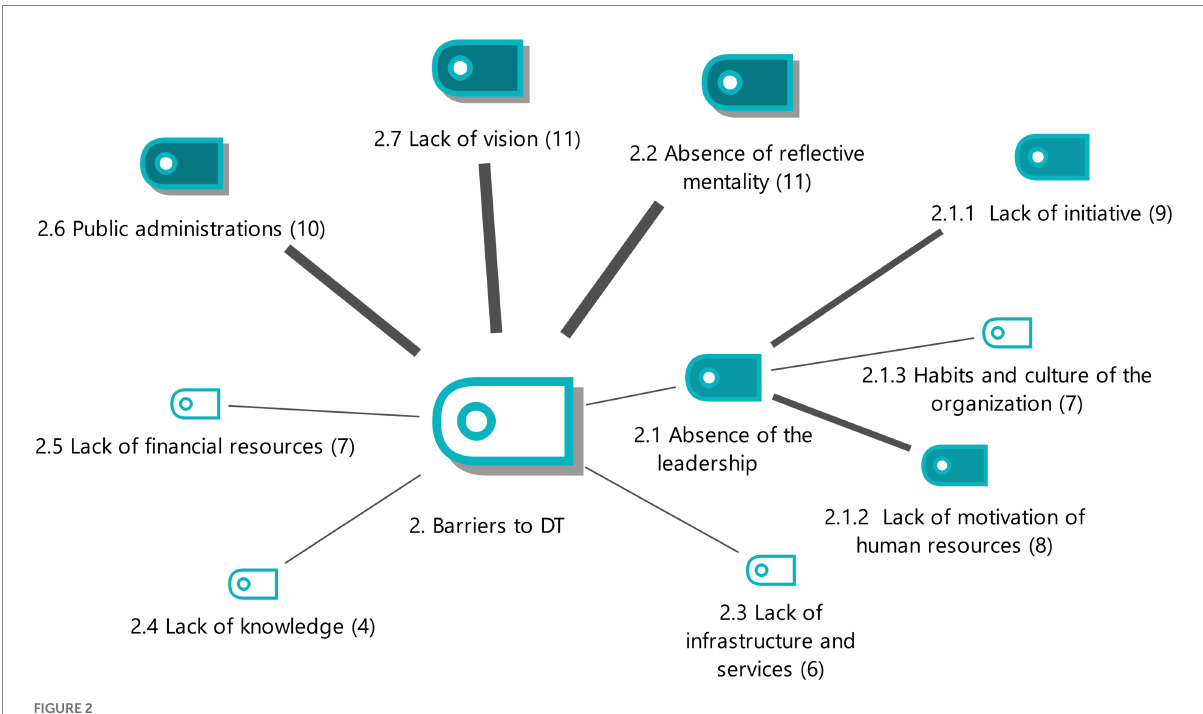
FIGURE 2 Barriers to DT with the weightings of the properties. Source: authors